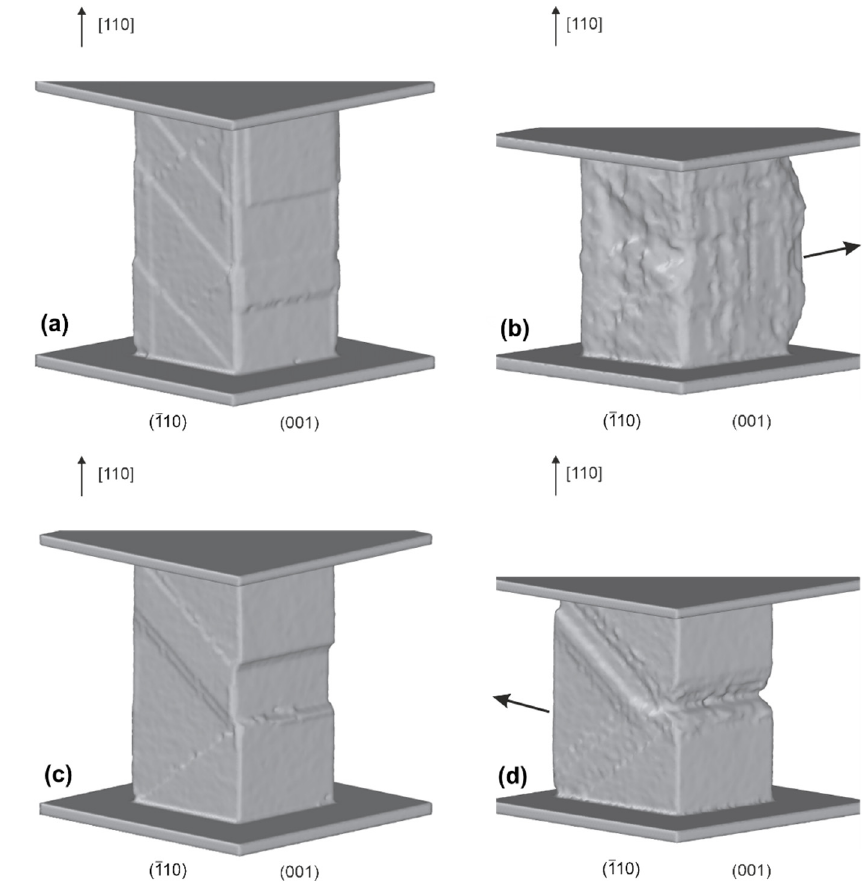
Figure 7. The deformation relief of simulated [110] ‐ single crystals, ε = 7% ( a , c ), 24% ( b , d ) (the con ‐ strained deformation conditions; ( a , b ) the free lateral face (cid:4666)11(cid:3364)0(cid:4667) ; ( c , d ) the free lateral face (cid:4666)001(cid:3364)(cid:4667)